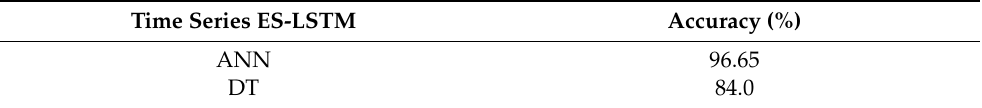
Table 6. Results of ANN and DT models.